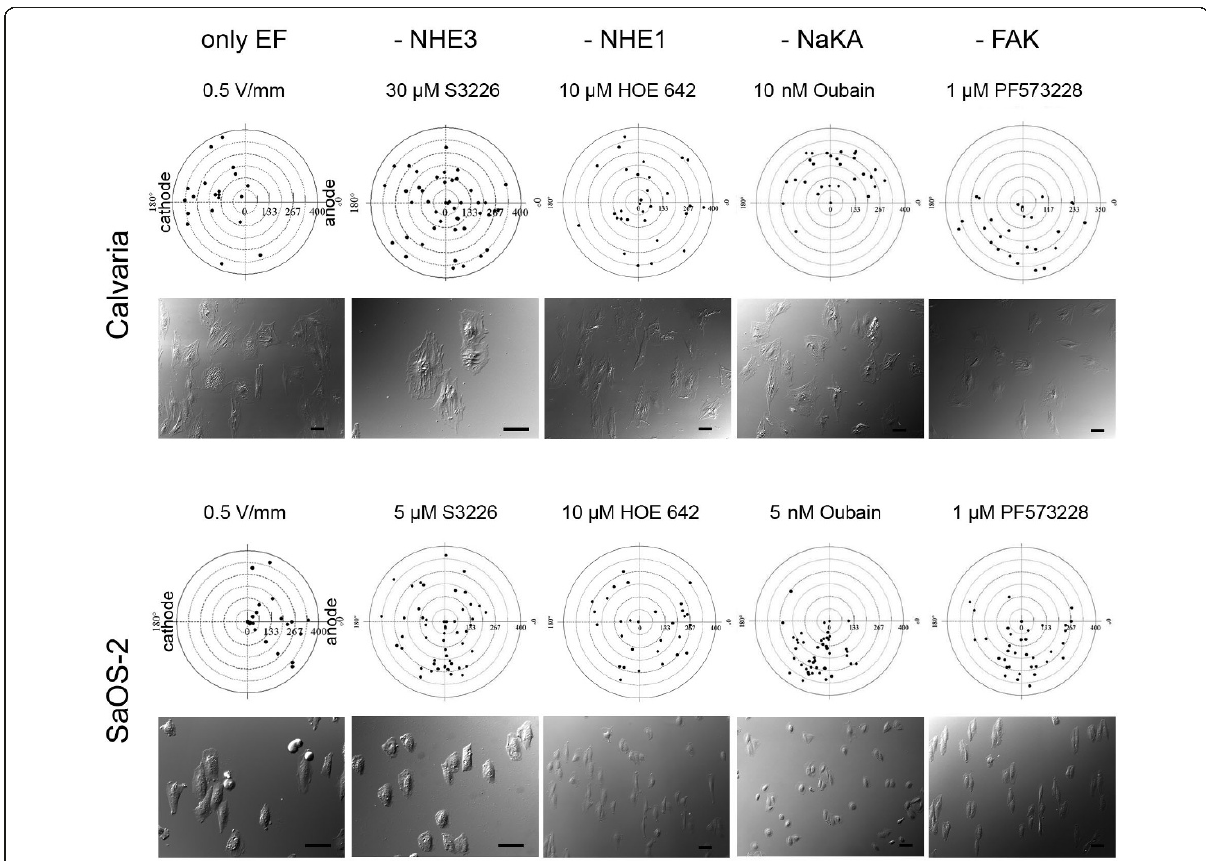
Figure 3 Polar diagrams representing the directedness of cathode (Calvaria)- and anode (SaOS-2)-directed cells in the presence of an applied EF or an EF in combination with the NHE3-, NHE1-, or NaKA-specific inhibitors, S3226, HOE 642, or oubain, respectively . FAK inhibition was used as a positive control. Each diagram represents the data from 25-45 cells from three to five individual experiments. DIC images showing the cell shape, morphology, and orientation in the presence of EF only or with inhibitors. Bars: 50 μ